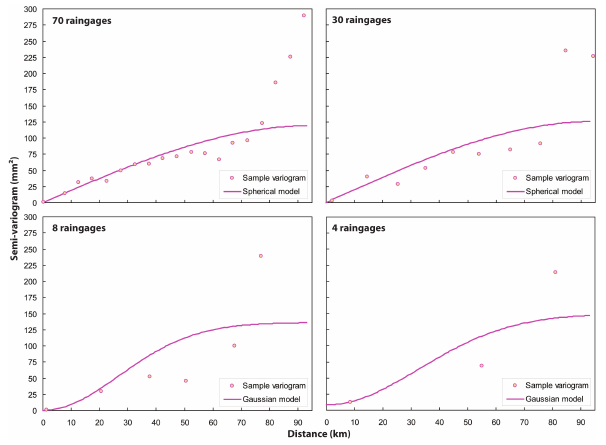
Fig. 4. Sample and theoretical semi-variograms for a day of winter (20 December 1993) made using 70, 30, 8 and 4 raingages. Table 1. Annual mean rainfall (in mm) of the Ourthe and Ambleve catchments, generated using six different methods and 70 raingages available in and surrounding the two catchments.